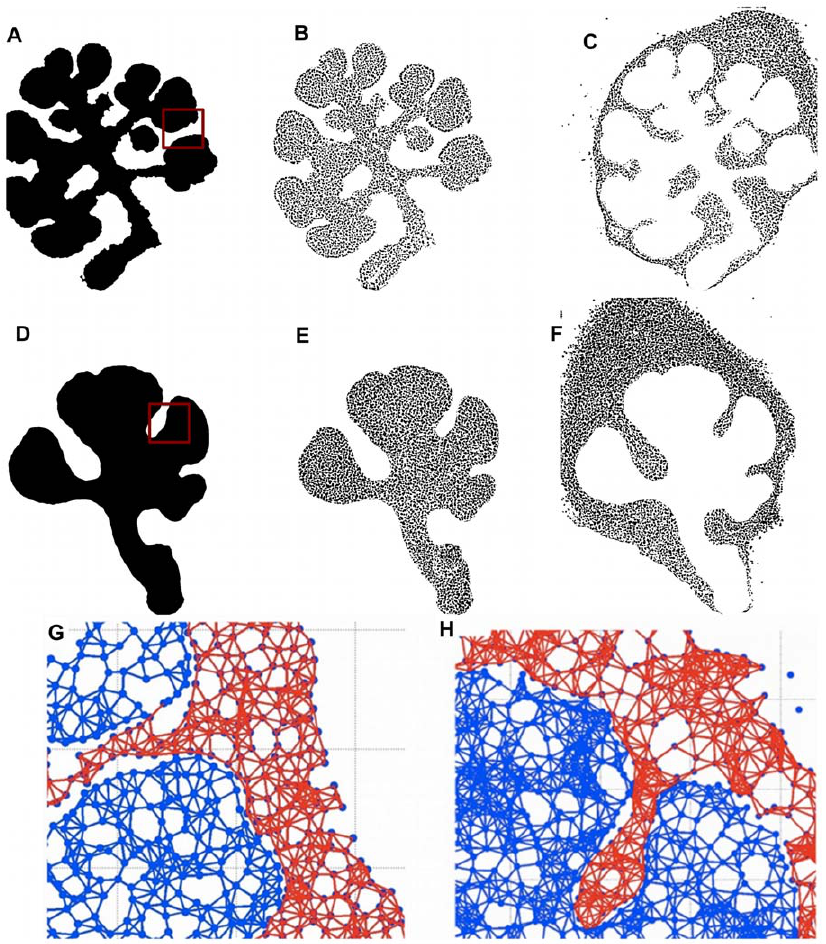
Figure 2. Generation of Cell Graphs. Stitched images were segmented using the active contour method to define epithelial (white) vs mesenchymal tissue (black) in control (a) and ROCK inhibitor-treated explants (d). These masks were used to identify the epithelial nuclei (b, e) and mesenchymal nuclei (c, f). Using each nucleus as a vertex, cell-graphs were constructed for control and ROCK inhibitor-treated tissues, respectively (g, h), where zoomed regions of cell graphs corresponding to regions of the original images (shown as red boxes in a and d) are shown in detail. Epithelial tissue is respresented by the blue graph and the mesenchymal tissue is represented by the red graph. We discarded the sublingual tissues and only used the submandibilar gland, (Figure S2).